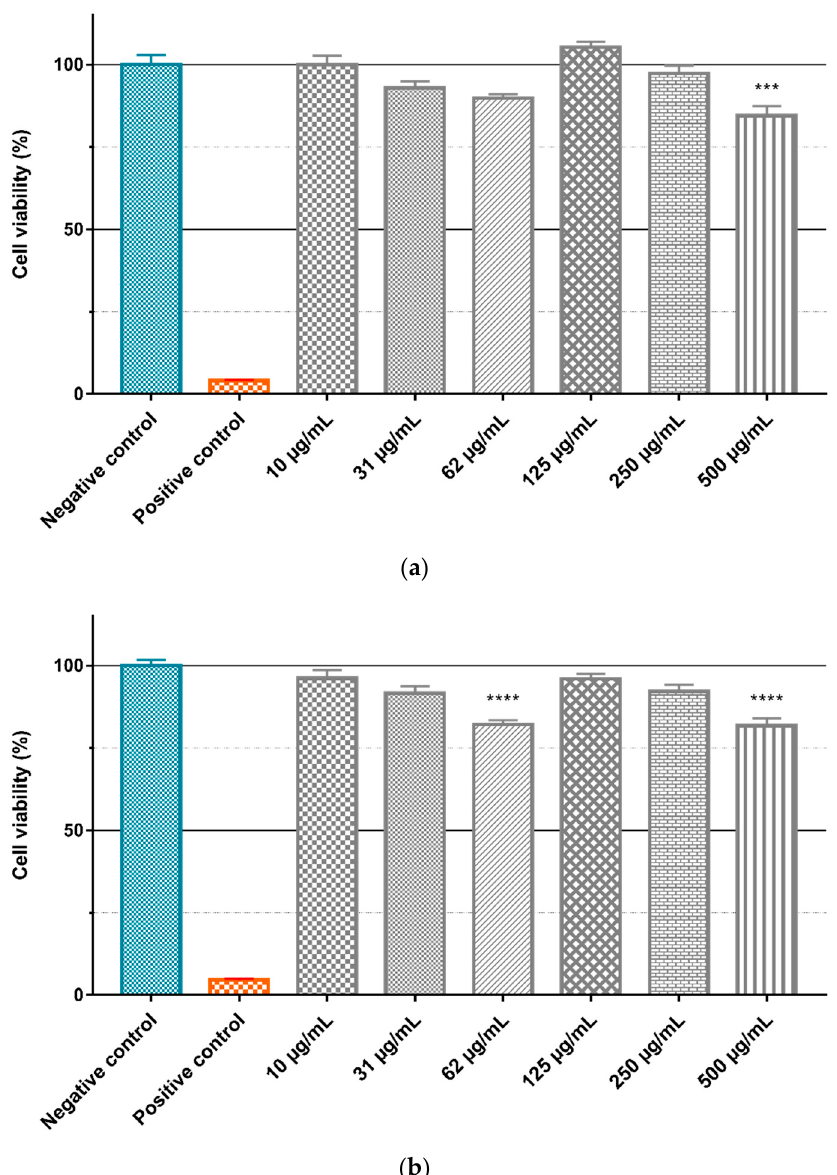
Figure 19. Evaluation of nanoparticle cytotoxicity by the MTT method. The VERO cell line was treated for 24 h in a suspension containing different concentrations of ( a ) Gd 2 O 3 :Eu 3+ and ( b ) SiO 2 - Gd 2 O 3 :Eu 3+ (1%) nanoparticles. The graphics represent the mean values + standard deviation of the means of three independent experiments. Negative control: cells in medium only. Positive control: cells treated with 0.4% ( v / v ) Triton X-100 (*** p = 0.0001, **** p < 0.0001).